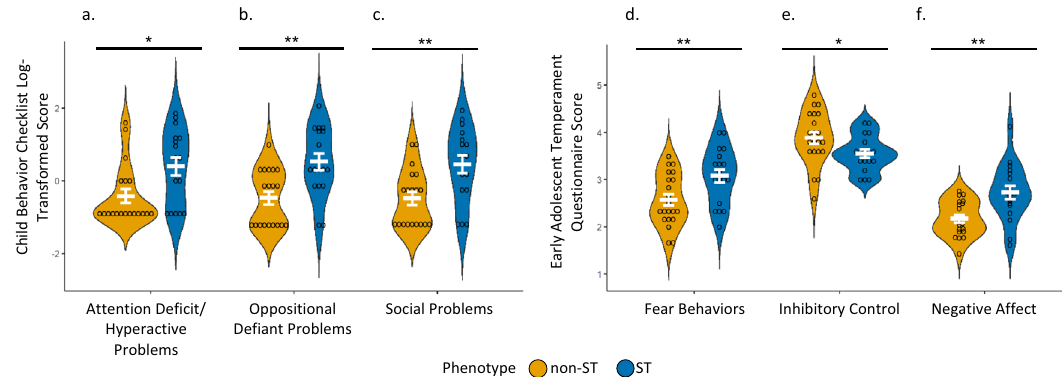
Figure 2. Violin plots illustrating phenotypic differences in externalizing behaviors. Plotted results of two-sided Welch two-sample t -tests measuring mean differences between phenotypes on parent-reported externalizing behaviors. ST = sign-trackers (n = 19); non-ST = non-sign-trackers (n = 21). p < .01**, p < .05* ( a – c ) Scores from the Child Behavior Checklist (CBCL) subscales log transformed. ( a ) Scores from the CBCL DSM-oriented subscale for attention deficit/hyperactive problems. ( b ) Scores from the CBCL DSM-oriented subscale for oppositional defiance. ( c ) Scores from the CBCL subscale for social problems including items relating to jealousy, not getting along with others, and not being liked by others. ( d–f ) Items from the Early Adolescent Temperament Questionnaire (EATQ). ( d ) Scores from the EATQ fear subscale address unpleasant affect related to anticipation of distress. ( e ) Scores on the inhibitory control subscale of the EATQ address the capacity to plan and suppress inappropriate responses. ( f ) Negative affect from the EATQ is a composite score of aggression, depression, and frustration